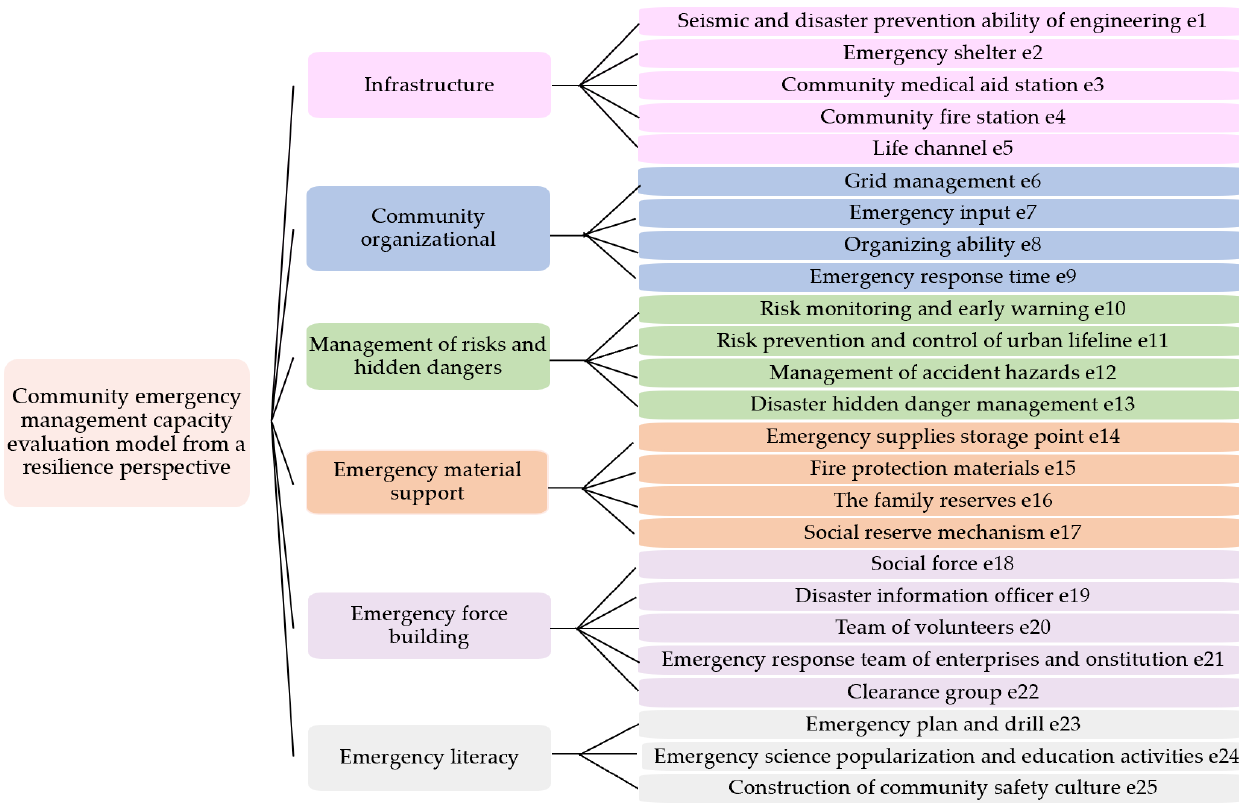
Figure 1. Community emergency management index system.